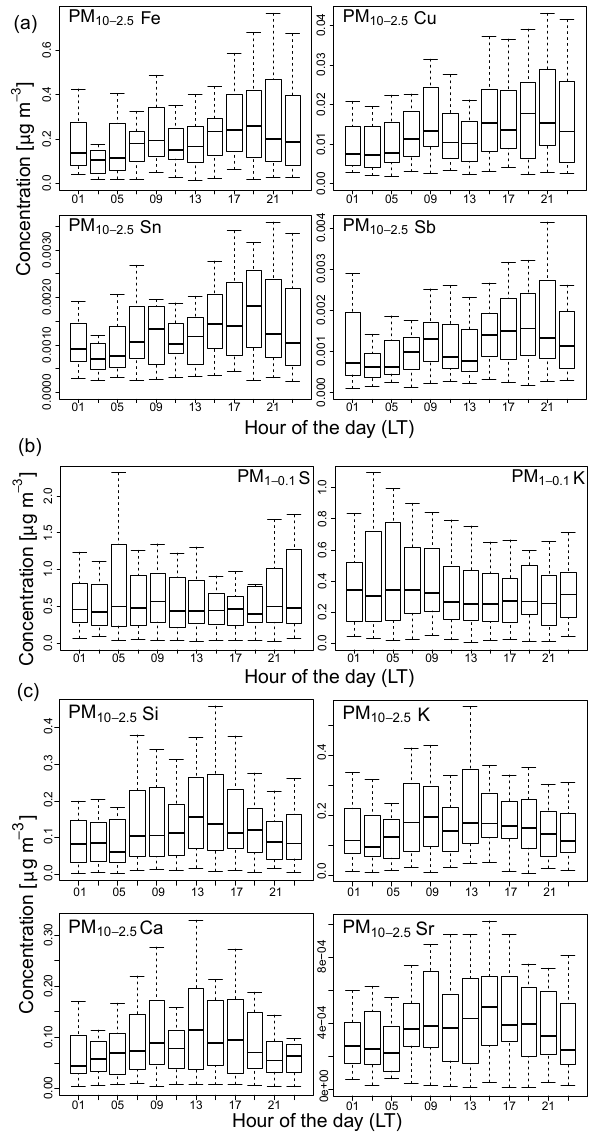
Fig. 2. Average diurnal variations of Fe, Cu, Sn and Sb in the largest size range, PM 10 − 2 . 5 , (a) and S and K in the smallest size range PM 1 − 0 . 1 , (b) . Coarse mode traffic related elements show a related pattern to morning and evening rush hours, whereas fine mode S and K show no clear diurnal variation. Panel (c) shows average diurnal variations of crustal elements Si, K, Ca and Sr in the largest size range, PM 10 − 2 . 5 . Elevated mass concentrations of mineral dust are found during midday and the variations are not as strong as for traffic related elements. Data during fireworks at New Years Eve from 31 December 2008 15:00 LT to 1 January 2009 05:00LT are excluded.